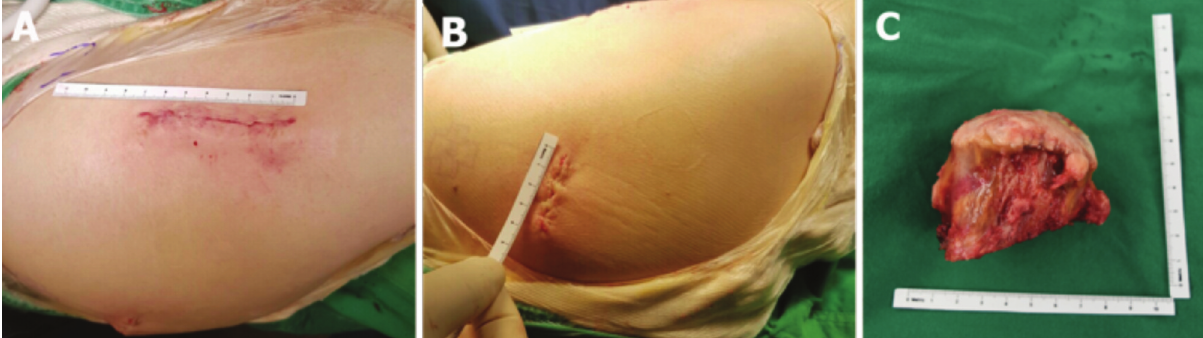
(a) The first anterolateral incision (7 cm) after wound closure. (b) The second posterolateral incision (4 cm) after wound closure. Fig. 2: (c) The excised femoral head and neck (size: 7x6x5 cm).